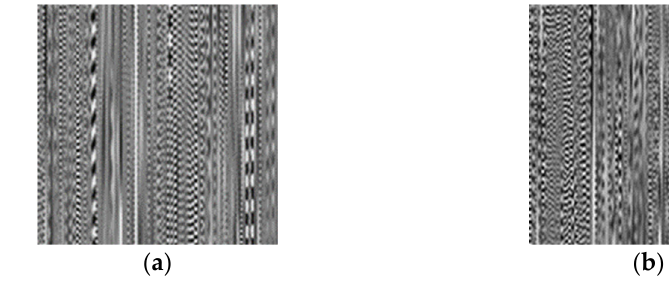
Figure 14. Example of grayscale image. ( a ) Normal; ( b ) Other.